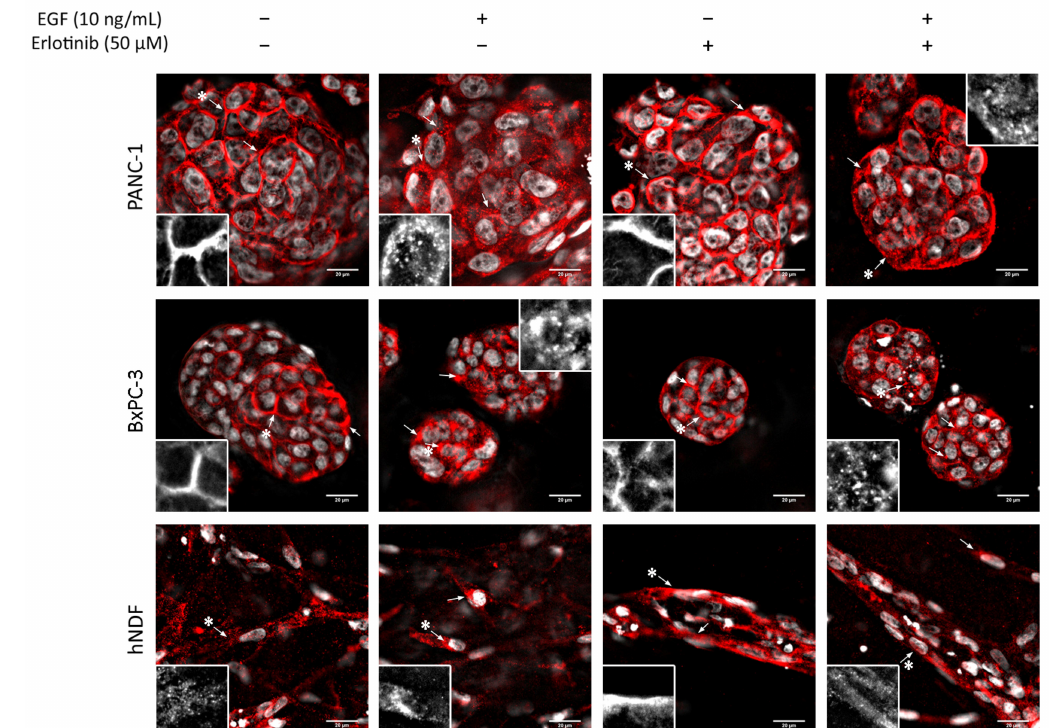
Figure 6. EGFR immunofluorescence in PANC-1, BxPC-3and hNDF cells incubated with EGF, erlotinib or both in 0.15% RAD16-I 3D cultures. One representative Z plane is shown. Scale bars represent 20 µ m. Insets represent high magnification images of the region indicated by an asterisk (*).